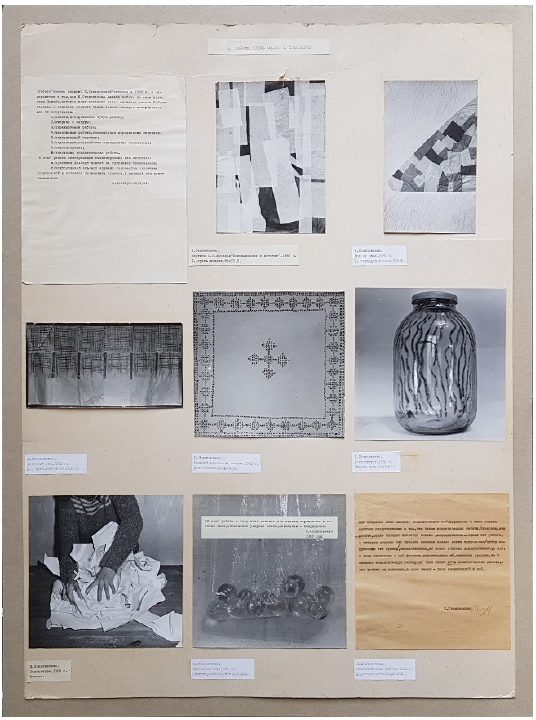
Figure 20. Albert. Eight Assignments for N. Stolpovskaia . 1980–1981. Paper, black-and-white pho- Figure 20. Albert . Eight Assignments for N. Stolpovskaia. 1980–1981. Paper, black-and-white photo- tographs. 84.4 cm × 61.5 cm. Courtesy of Yuri graphs. 84.4 cm × 61.5 cm. Courtesy of Yuri Albert.